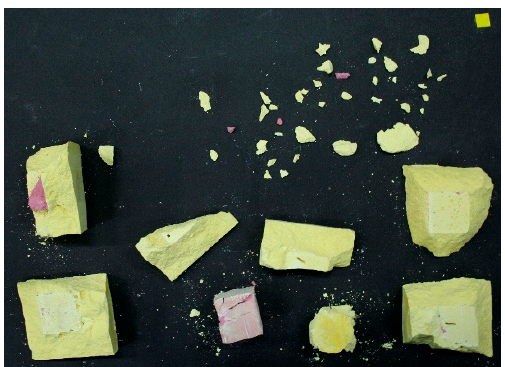
Figure 11. Image of crushed low-grade ore with a detached red grain.